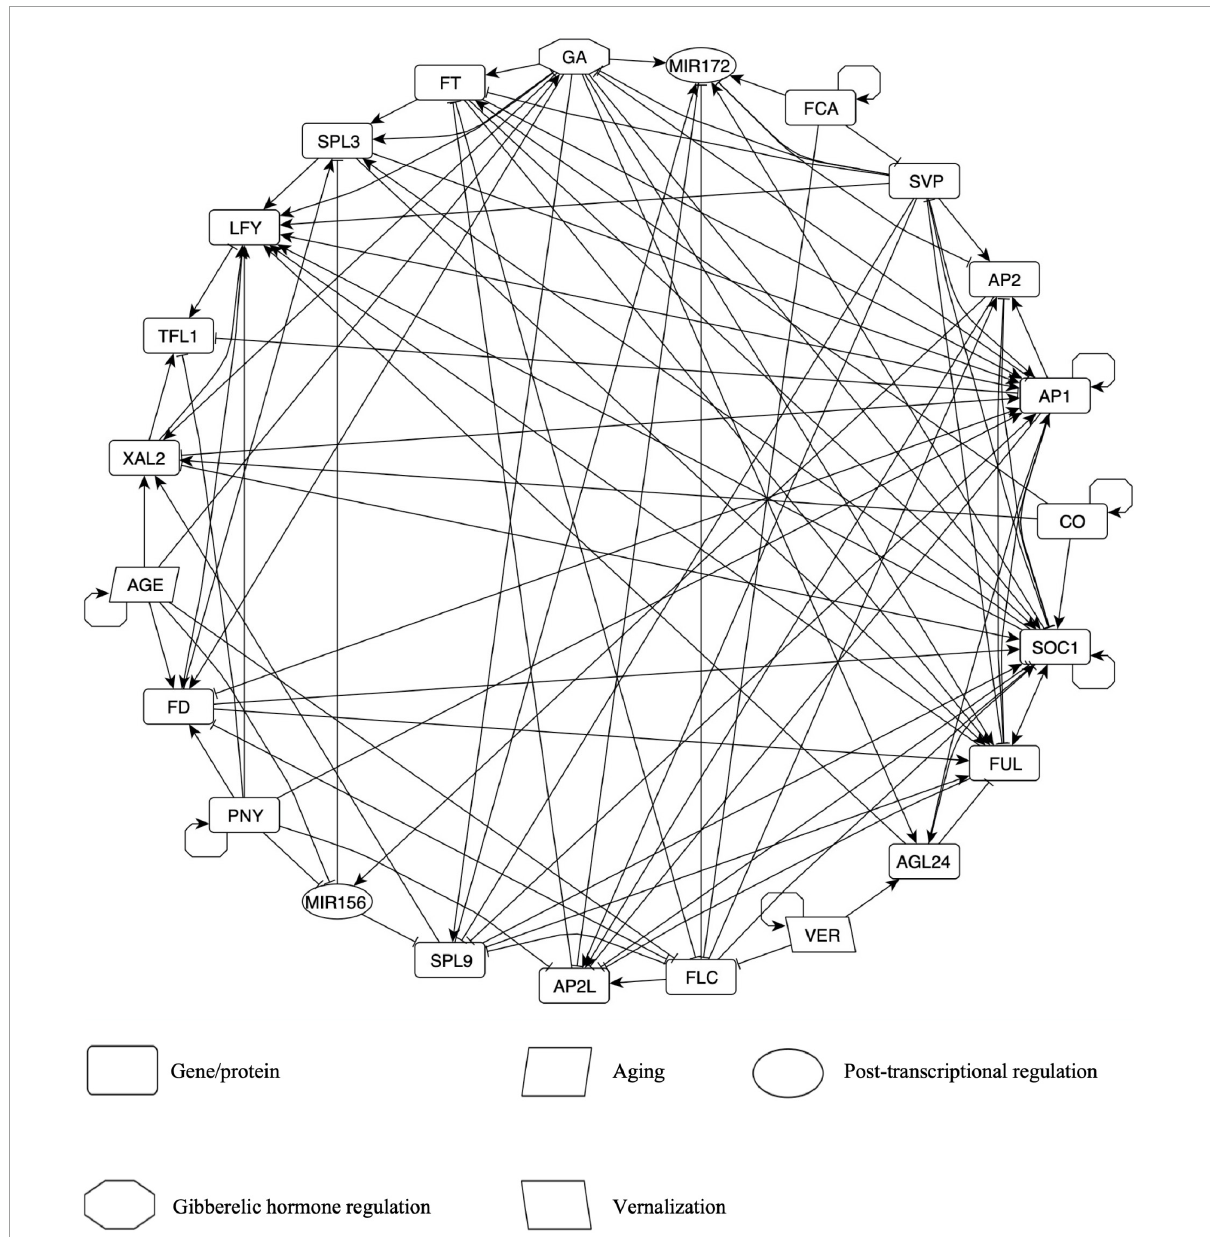
FIGURE2 The Flowering Transition Gene Regulatory Network (FT-GRN) in A. thaliana, which integrates photoperiod, vernalization, and endogenous signals, is highly connected. Edges represent either positive (arrow) or negative (T-shape line) regulatory interactions. All interactions are based on hand-curated experimental data. Nodes in clockwise order are: GA; MIR172; FCA; SVP; AP2; AP1 includes CAL and AP1 ; CO; SOC1; FUL; AGL24; VER, vernalization; FLC; AP2L node includes TOE1-3, SMZ, and SNZ ; SPL9 node includes SPL9 and SPL15 ; MIR156; PNY node includes POUND-FOOLISH ( PNF ) and PENNYWISE ( PNY ); FD node includes FD PARALOG (FDP) and FD ; AGE; XAL2; TFL1; LFY; SPL3 node includes SPL3, SPL4, and SPL5 ; FT node includes TWIN SISTER OF FT ( TFS ) and FT. Also see Supplementary Table 2 for